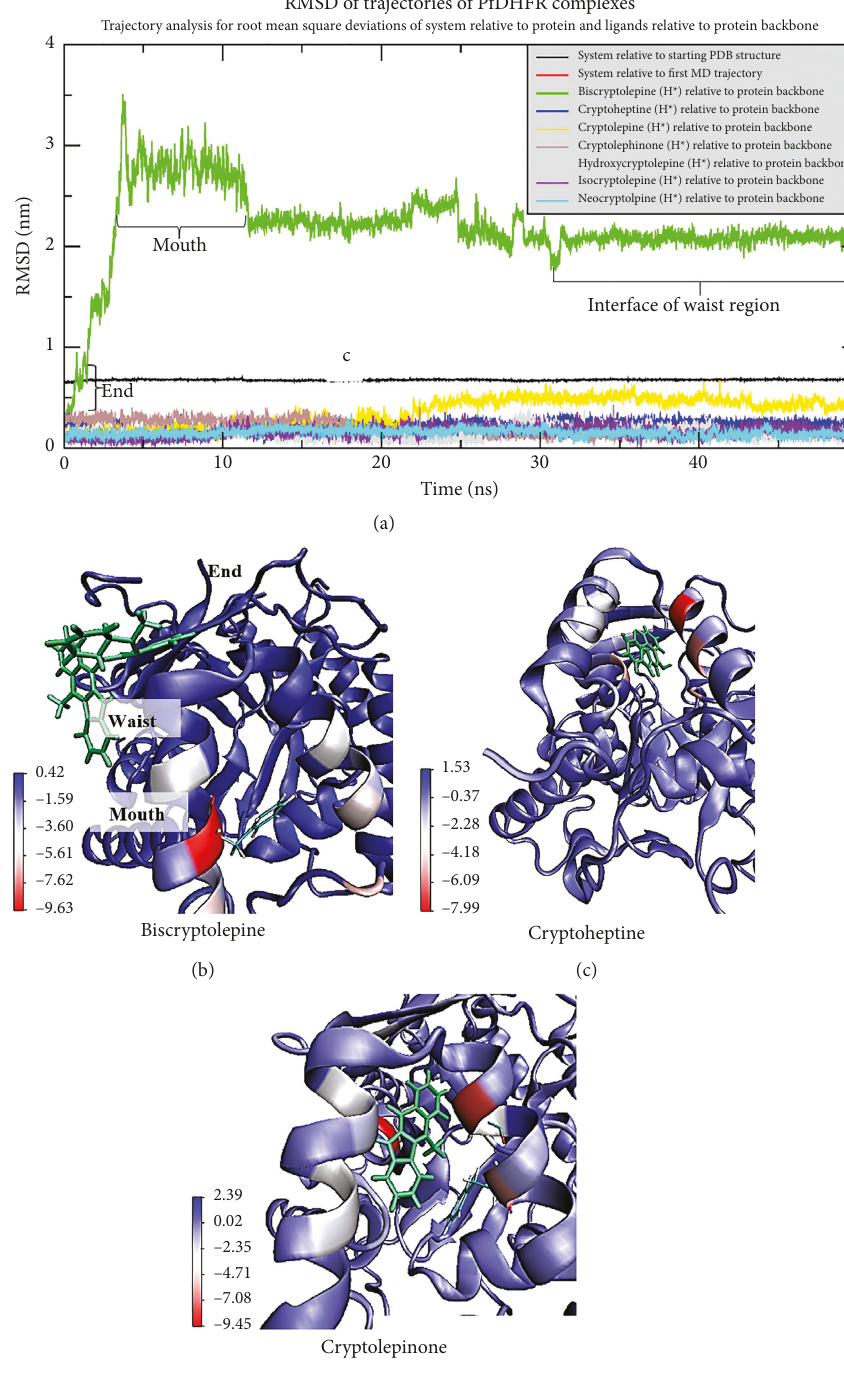
Figure 12: Binding conformation predicted from molecular docking was stable under dynamic conditions for all complexes. (a) Trajectory showing stability of protein ligand complexes. Biscryptolepine was observed to be bound strongly at the end of the quinone-binding tunnel for ∼ 1.5ns. Displacement by solvent access increased RMSD (from ∼ 0.5 nm to 2.5nm), however, good binding along the mouth between 2ns and 12ns, followed by the periphery (interface) of the waist region from 13ns to 50ns (average RMSD favorably. All ligand complexes involving alkaloids of the pg class were stable throughout the simulation (average RMSD Interacting residues contributing to binding affinity have been colored based on b-factors (b–d). Biscryptolepine (b) interacted strongly with the alpha helical bundle, whereas cryptoheptine (c) and cryptolepinone (d) strongly interacted in the inhibitor (teriflunomide) binding domain of the quinone-binding